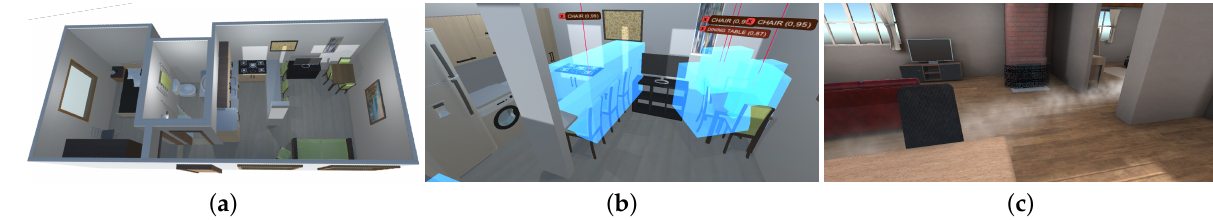
Figure 1. Illustration of the integration of artificial vision and gas sensing systems in a realistic simulated environment. ( a ) Recre- ation of a small flat including a wide variety of objects. ( b ) Simulated image captured by a virtual camera, where objects have been detected and localized (blue bounding boxes). ( c ) Visualization of a gas plume within a similar